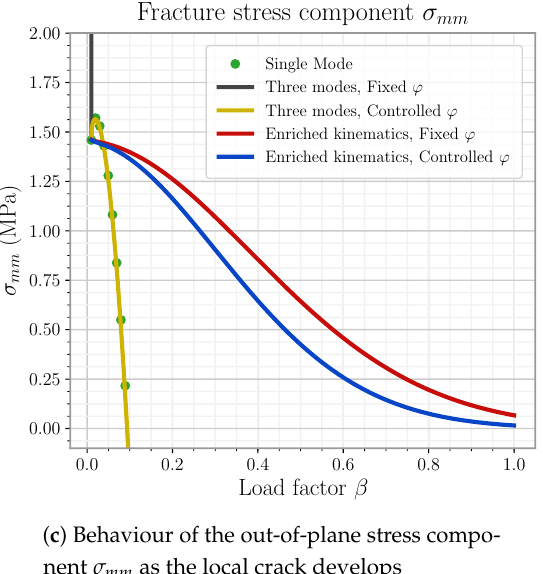
Figure 16. Comparison of the response for stress state components ( a ) σ tt , ( b ) σ tm and ( c ) σ mm as the local crack kinematics develops completely for all five formulations currently